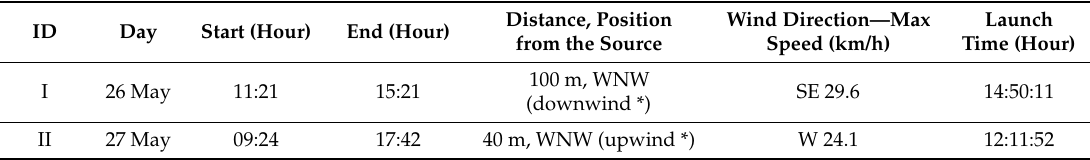
Table 2. Sampling time, sampler position and meteorological conditions during inert bomb